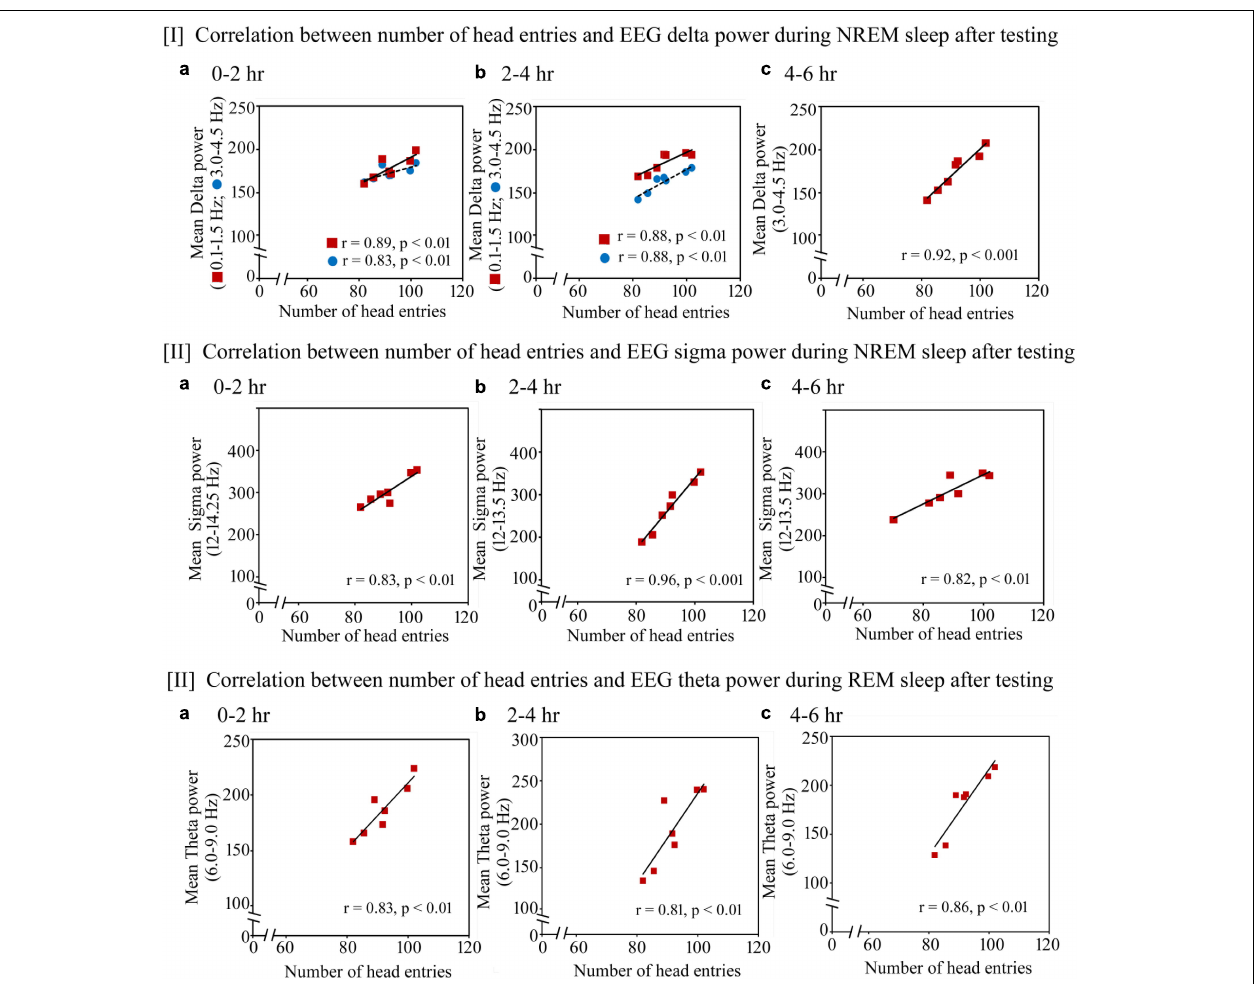
FIGURE 8 | Pearson correlation between performance and percent change in cortical oscillatory waves during NREM and REM sleep during the testing day. On the testing day, (I) the number of head entries positively significantly correlated with the increased power of SWA waves in the range of 0.1–1.5 Hz ( r = 0.89; p < 0.01) and 3–4.5 Hz ( r = 0.83; p < 0.01) at 0–2 h (a) ; 0.1–1.5 Hz ( r = 0.88; p < 0.01) and 3–4.5 Hz ( r = 0.88; p < 0.01) at 2–4 h (b) and 3–4.5 Hz ( r = 0.92; p < 0.001) at 4–6 h (c) ; (II) the power in sigma range during NREM sleep also significantly positively correlated with performance in the range of 12–14.25 Hz at 0–2 h ( r = 0.83; p < 0.01) (a) and in the range of 12–13.5 Hz at 2–4 h ( r = 0.96; p < 0.001) and 4–6 h ( r = 0.82; p < 0.01) (b,c) ; (III) theta power (6–9 Hz) during REM sleep also significantly positively correlated with performance during 0–2 h ( r = 0.83; p < 0.01), 2–4 h ( r = 0.81; p < 0.01) and 4–6 h ( r = 0.86; p < 0.01) (a–c) .